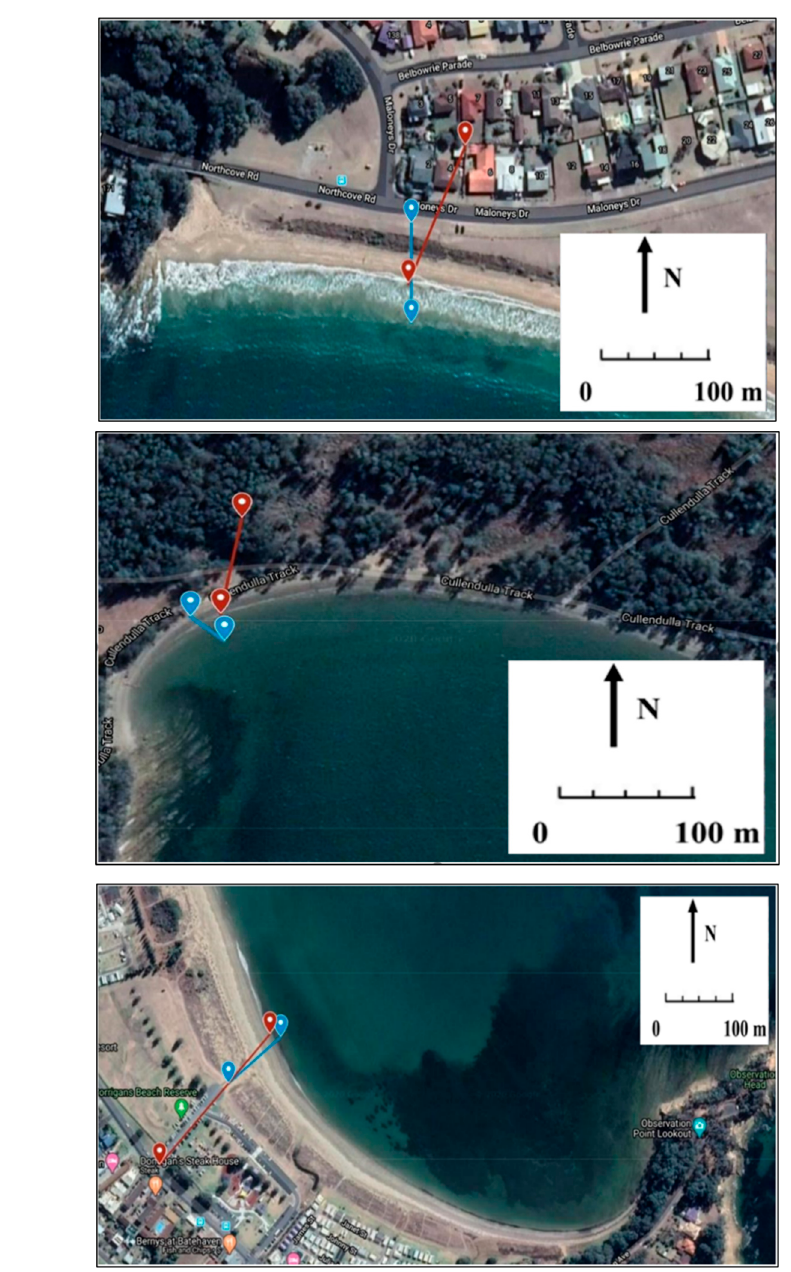
Figure 3 : ( a ) Maloney’s Beach, with field data profiles marked in blue and 2018 Block E Profile 8 marked in red; ( b ) West Cullendulla Beach, with field data profiles marked in blue and 2018 Block Y Profile 1 marked in red; and ( c ) South Corrigans Beach, with field data profiles marked in blue and 2018 Block X Profile 23 marked in red (source: Google Maps).